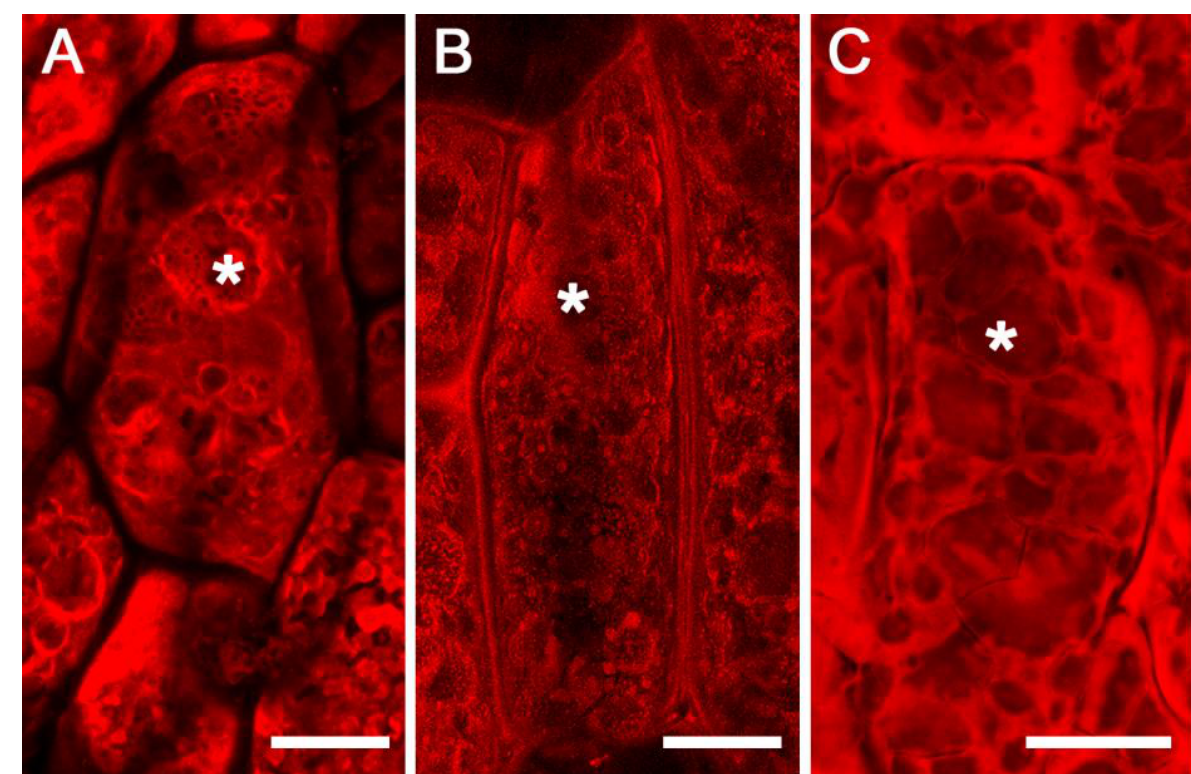
Figure 5. Maximum projection confocal images of eosin-stained soybean cotyledons. Free-hand section ( A ), vibratome section ( B ), and cryostat section ( C ). Asterisks indicate protein storage vacuoles. Scale bars for ( A – C ) are 20 µm.